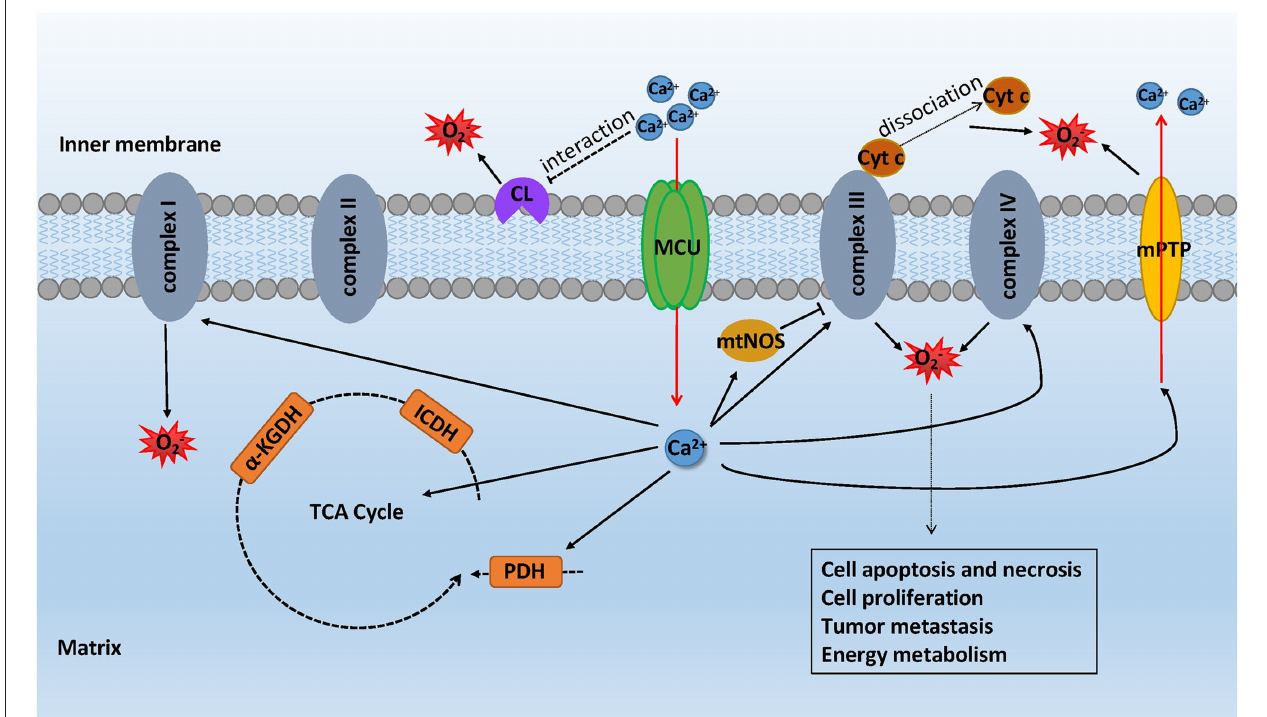
FIGURE 3 | mROS formation mediated by MCU-dependent calcium uptake. With the stimulation of oxidative stress, the elevated mCa 2 + took up by MCU interrupts energy metabolism causing the generation of mROS while the mROS formation can impact the cell metabolic function in turn. mCa 2 + increases the activity of glycerol phosphate dehydrogenase (GPDH), pyruvate dehydrogenase (PDH), isocitrate dehydrogenase (ICDH), and α -ketoglutarate dehydrogenase ( α -KGDH) in the TCA cycle, thus promoting mROS production. mtNOS, activated by mCa 2 + , hampers the conduction of electron, making complexes I and III generate mROS. mPTP opening results in the rupture of the outer membrane and thus causing the release of cytochrome c. Overloaded mCa 2 + has an effect on Ca 2 + -CL binding, inducing the reorganization of membrane components, which causes the high-rate generation of mROS at the ubiquinone level.